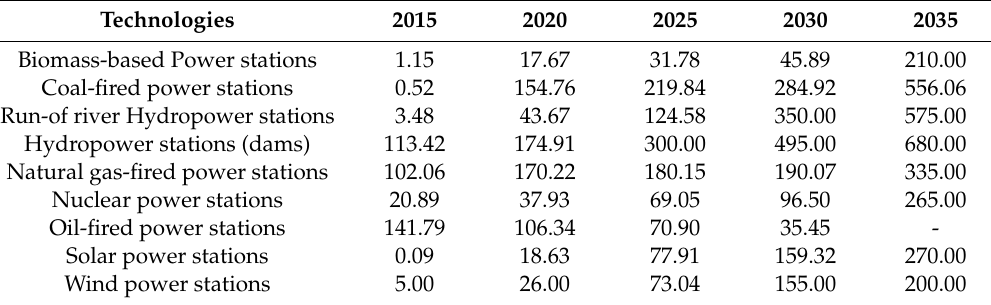
Figure 6. Increase in electricity generation (PJ) using various technologies (BAU scenario). Table 1. Electricity production (PJ) and technological mix in BAU scenario.